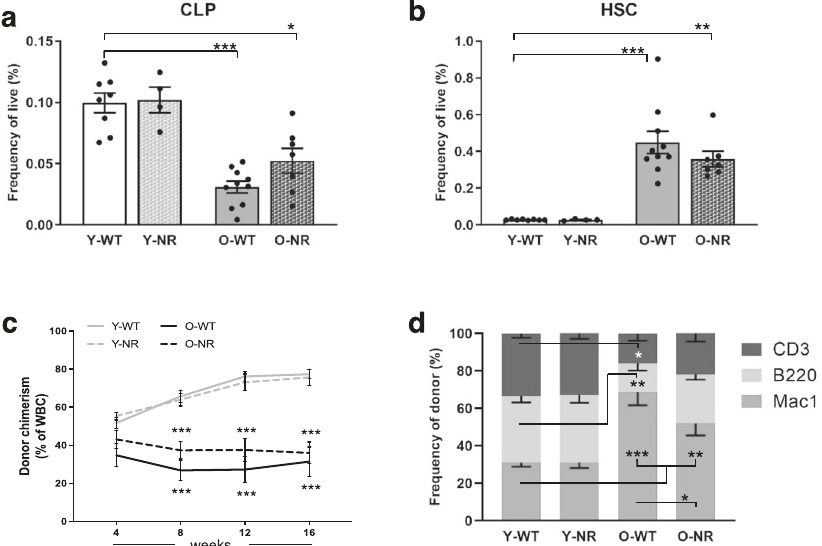
Fig. 2 NR treatment improves the lymphoid potential of HSCs from aged mice. a , b Frequency analysis of early progenitor compartments in NR-treated (NR) or untreated bone marrow from young (Y-WT, 3 – 4 months) or aged (O-WT, 24 – 29 months) mice ( n = 4 – 10). c Peripheral blood chimerism generated from 200 puri fi ed HSCs against 2 × 10 5 competitor cells every 4 weeks for 4 months ( n = 10). d Lineage composition of donor derived peripheral blood 4 months post transplant ( n = 10). Data are represented as mean ± SEM. Kruskal – Wallis test for a and b , two- way ANOVA for c and d : <0.05*, <0.01**,